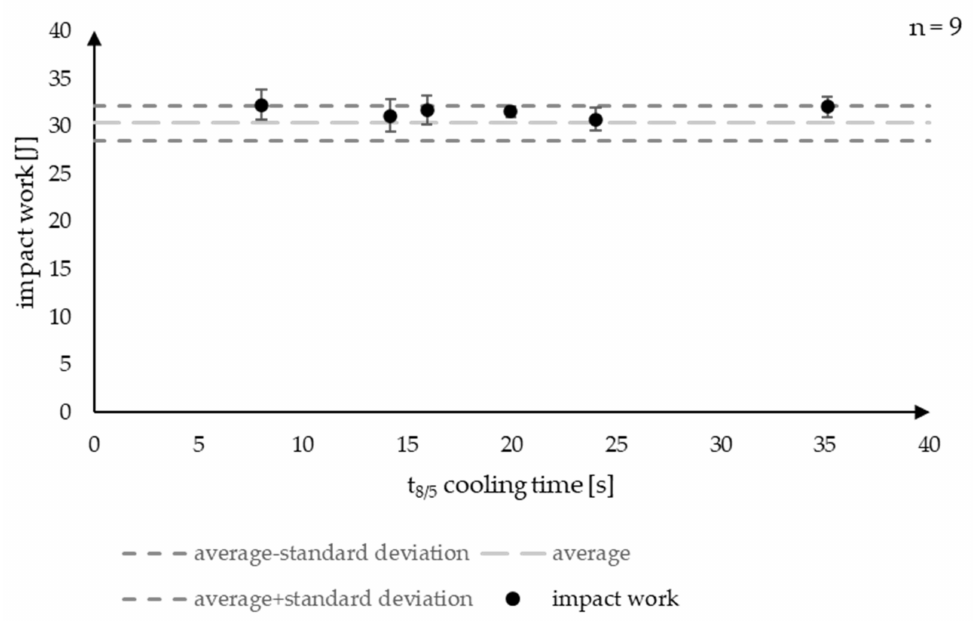
Figure 11. Charpy impact test over t 8/5 cooling time from measured